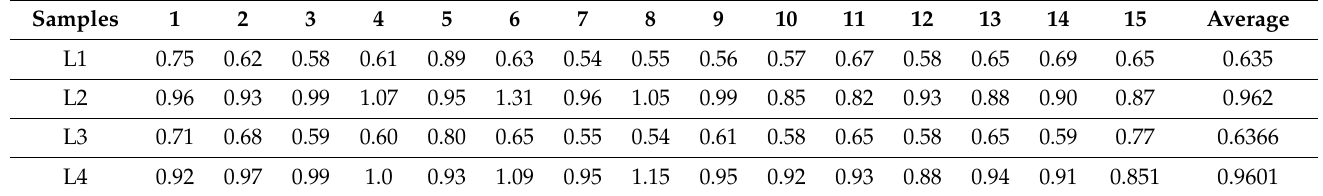
Table 2. Measurements of leather thickness in